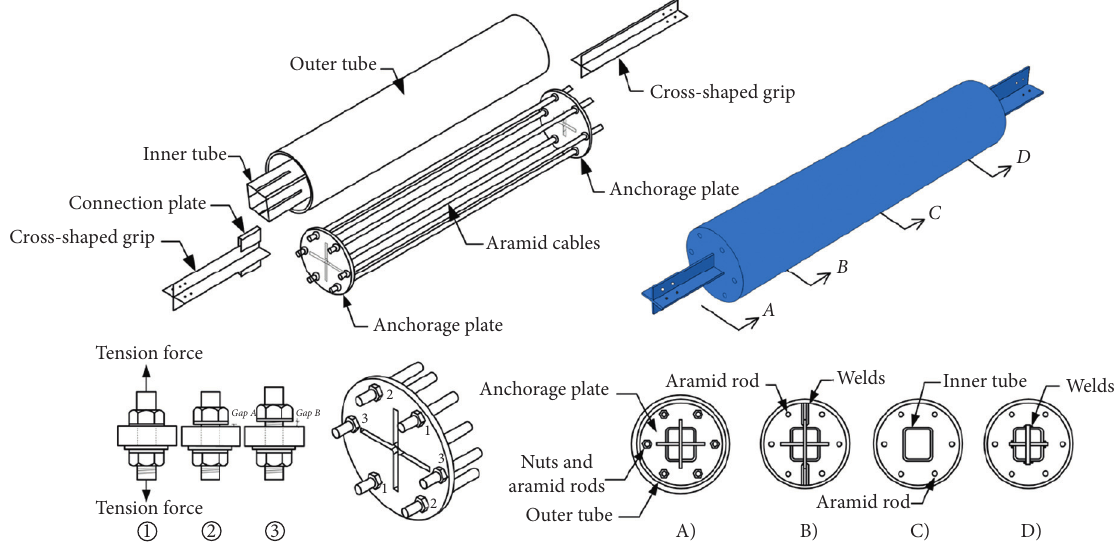
Figure 16: Embodiment of CLSC brace (adapted from [76]).